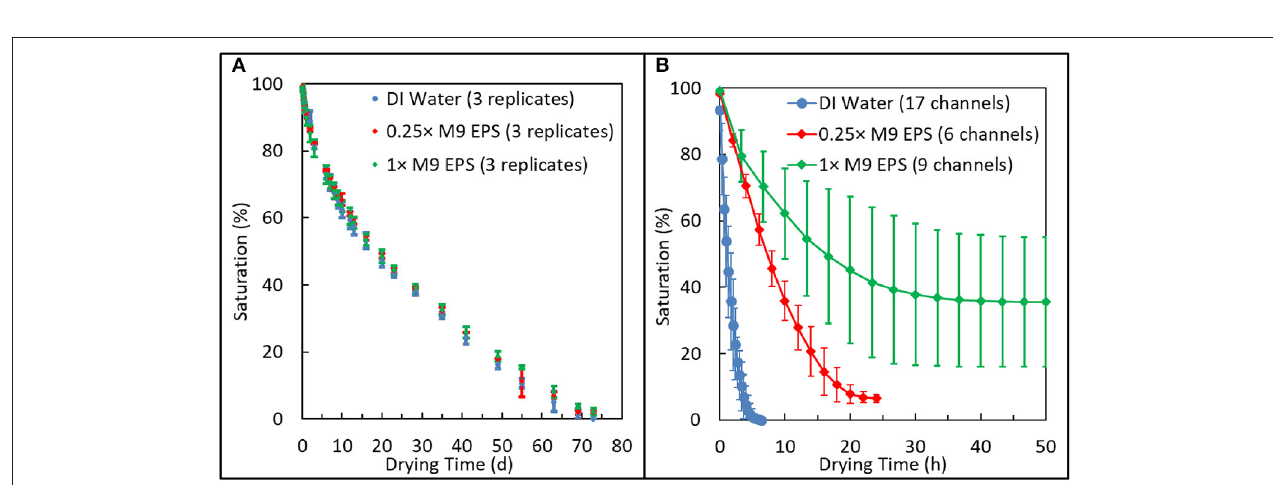
FIGURE 3 | Comparison of relative drying behavior of 1 × and 0.25 × extracellular polymeric substance (EPS) solutions suspened in M9 media at the macroscale and in an emulated soil geometry. (A) Glass capillary system shows all three solutions dried at similar rates and to similar extents in the macropore regime. (B) Emulated soil micromodel systems shows how EPS acts with microstructured physical geometry to dramatically reduce the rate and extent of drying and to enhance variability in pore-scale moisture